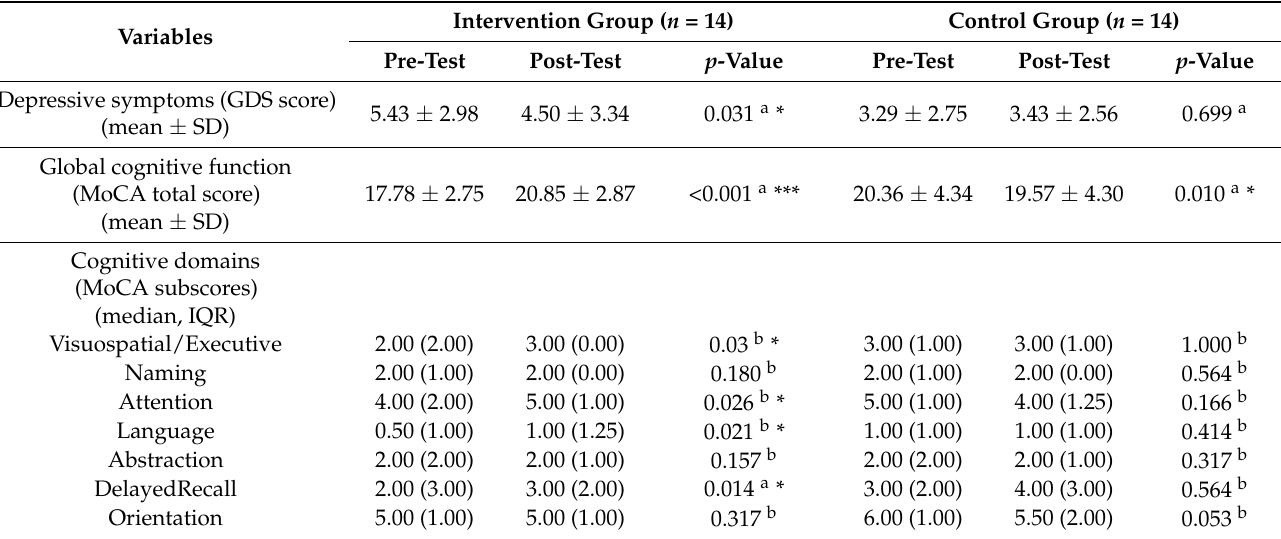
Table 2. Pre–post changes on depressive symptoms and cognitive performance within the interven- tion group and the control